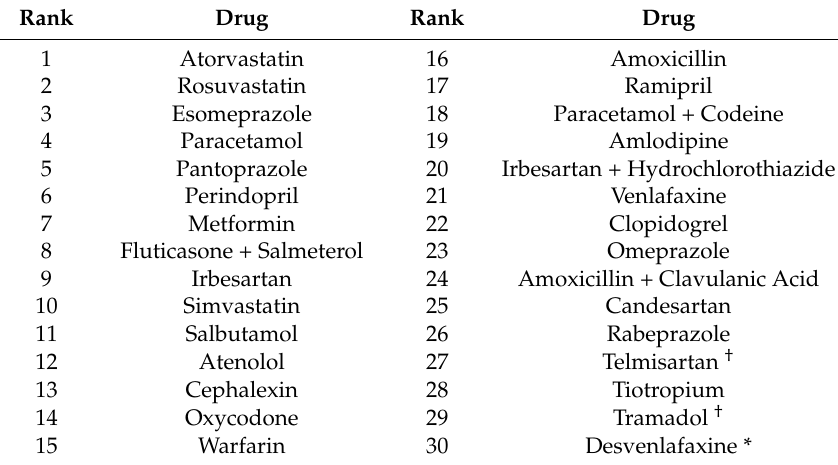
Table 1. Top 30 commonly-prescribed medicines by generic name (June